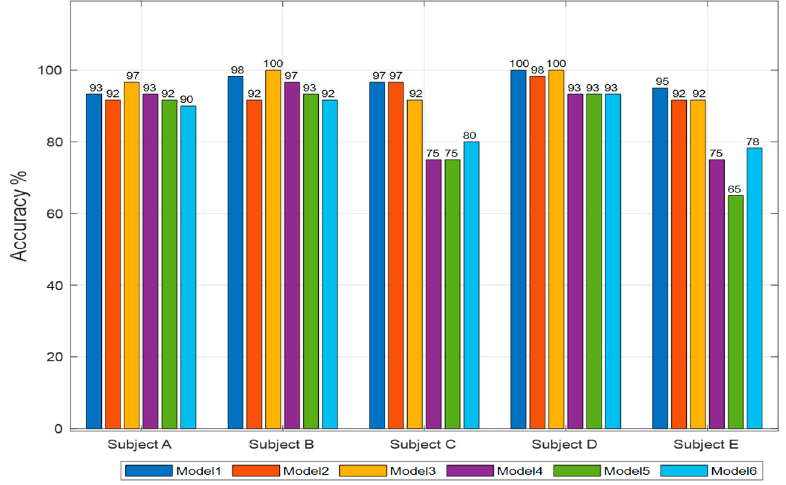
Figure 4. Average classification accuracy percentages over five subjects with six models.